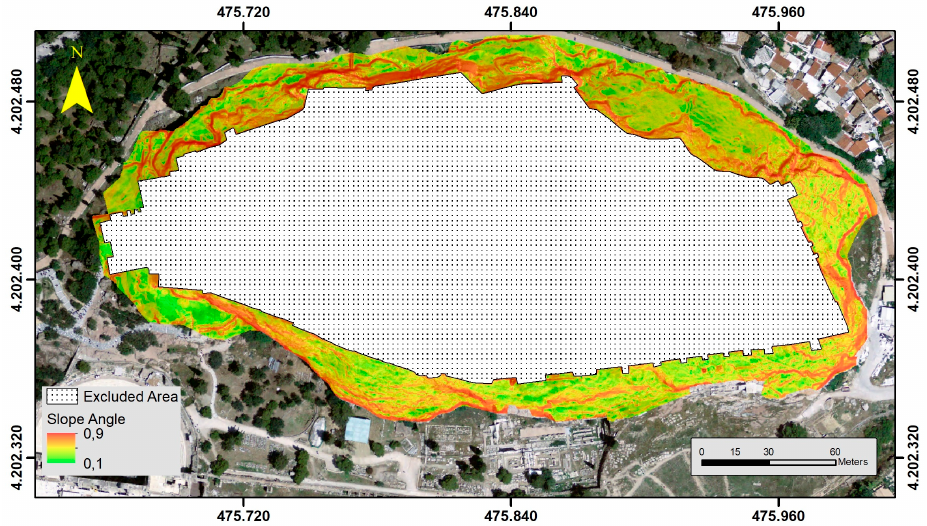
Figure 5. Instability related parameters (normalized): Slope Angle.